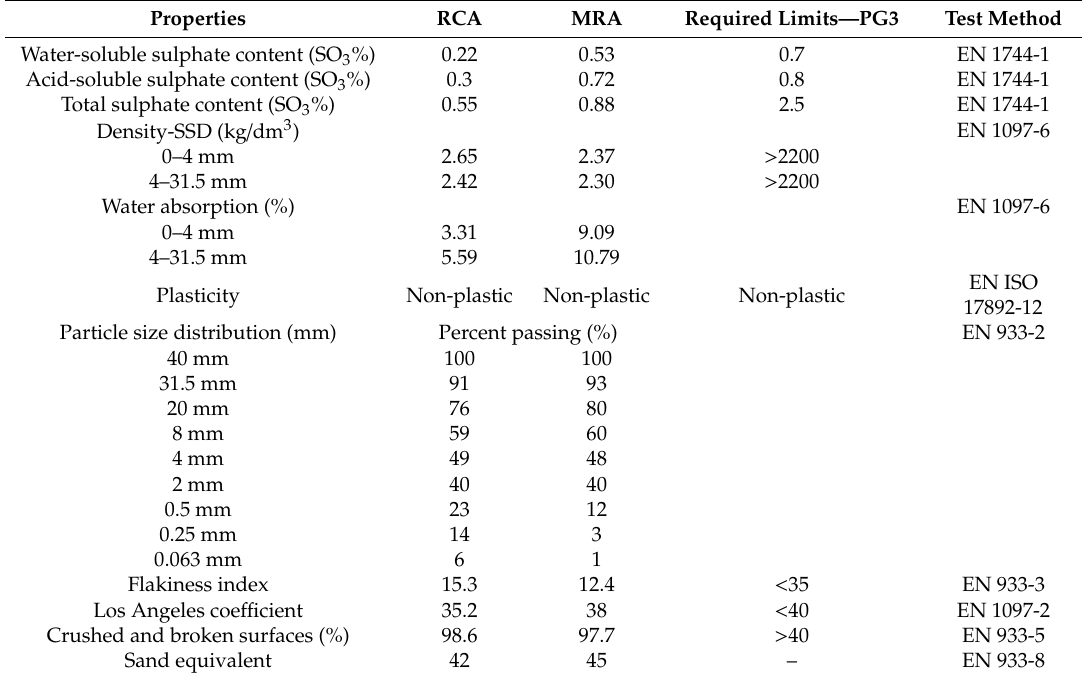
Table 3. Physical and geometric properties of recycled